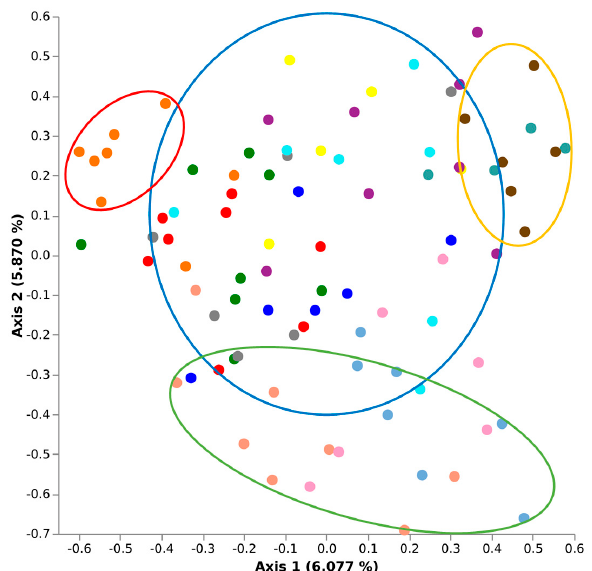
Figure 4. Jaccard similarity plots demonstrating a geographical effect on the Biogeography Seed microbiomes; Ashburton (central, blue), Aylesbury (north, red), Temuka (south, orange), and Kirwee (north, green) rings.